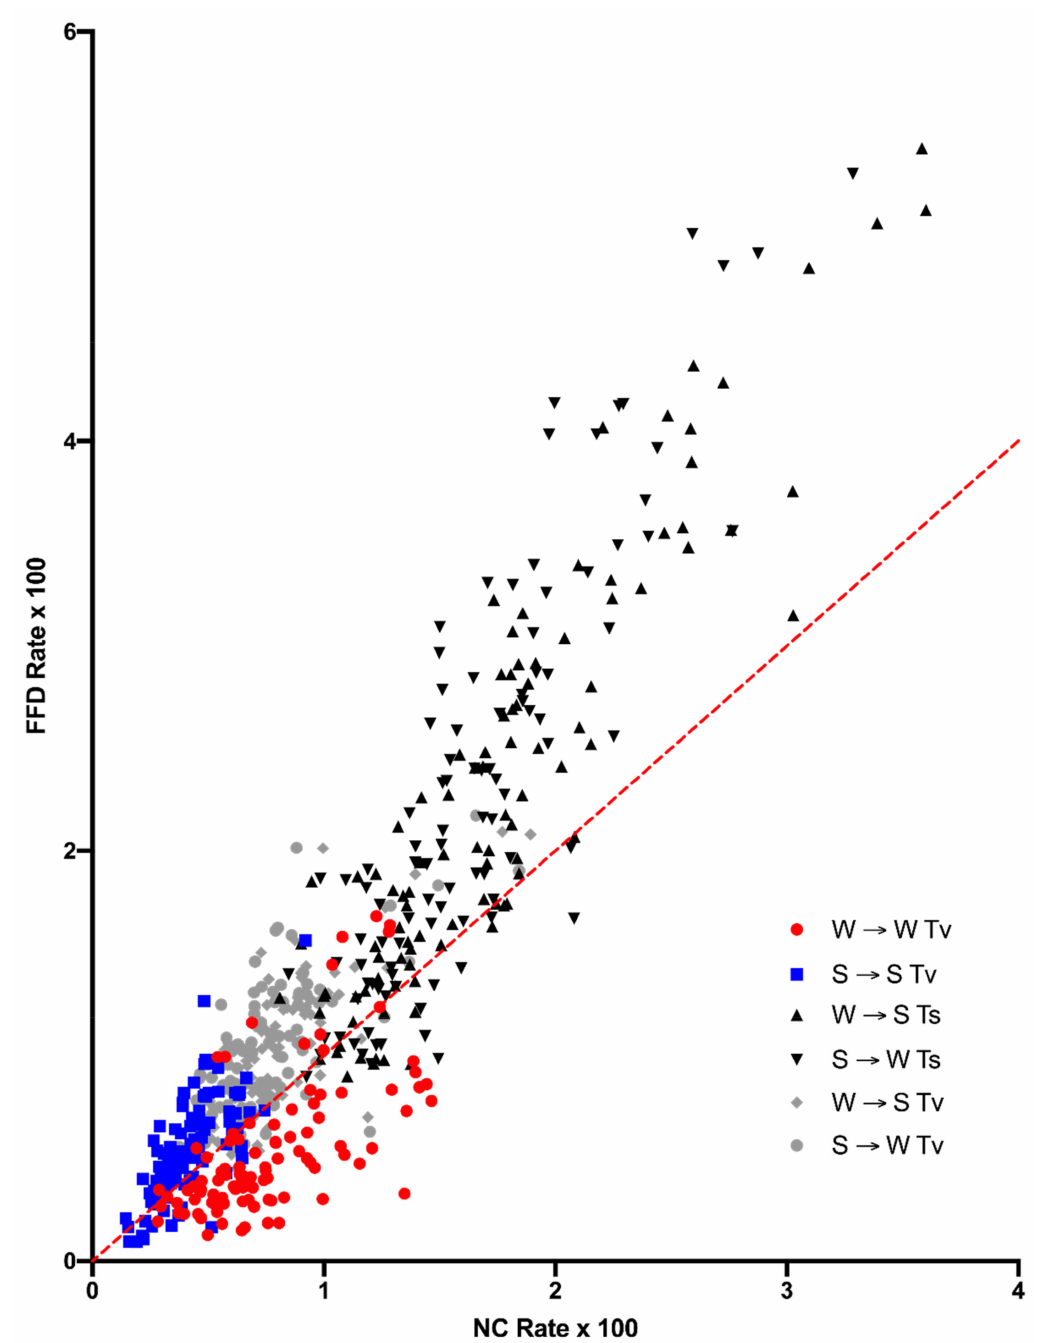
Figure 2. Rates of specific mutation types compared between NC and FFD sites, with the rate calculated as in Figure 1 and the equality line in red. Confidence intervals are omitted for clarity. The W-W substitutions (red circles), which are the A → T and T → A transversions, are below the equality line in 85% of the cases, while all others are above the equality line in about 87% of the